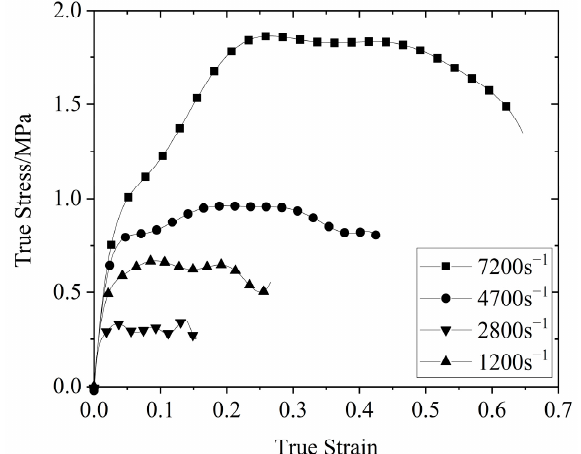
Figure 5. Stress–strain curve of silicone rubber at room temperature (26 °C) and different strain rates.